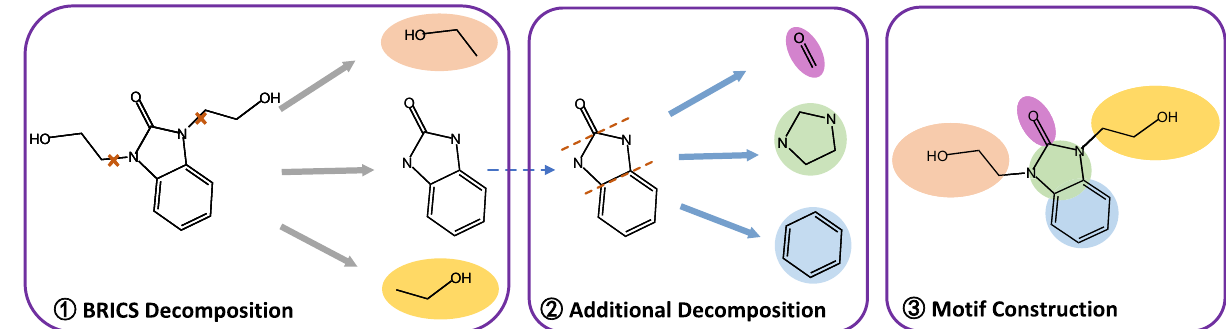
Supplementary Table 1. Different from other baselines, the initial molecular features of our HiMol contain degrees of atom nodes and whether bonds are in rings, which contain more molecular structural information. Our proposed HMGNN can encode molecular graphs to obtain multi-level representations simultaneously, including atom-level, motif-level, and molecule-level representations. The learned molecule-level representation can be directly used for downstream tasks, without the READOUT operation.